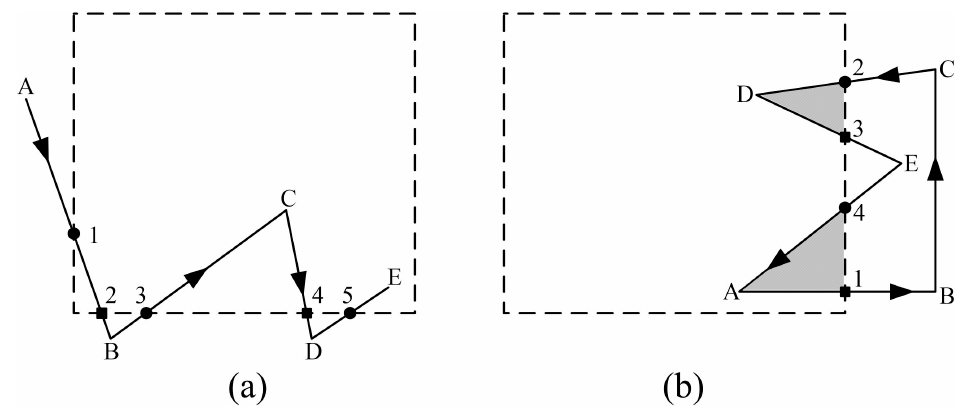
Figure 8. Schematic diagram of the clipping of paths consisting of several linear segments: ( a ) Polyline “A-B-C-D-E” has entry points 1, 3, and 5 and exit points 2 and 4; ( b ) Polygon “A-B-C-D-E-A” has entry points 2 and 4 and exit points 1 and 3.